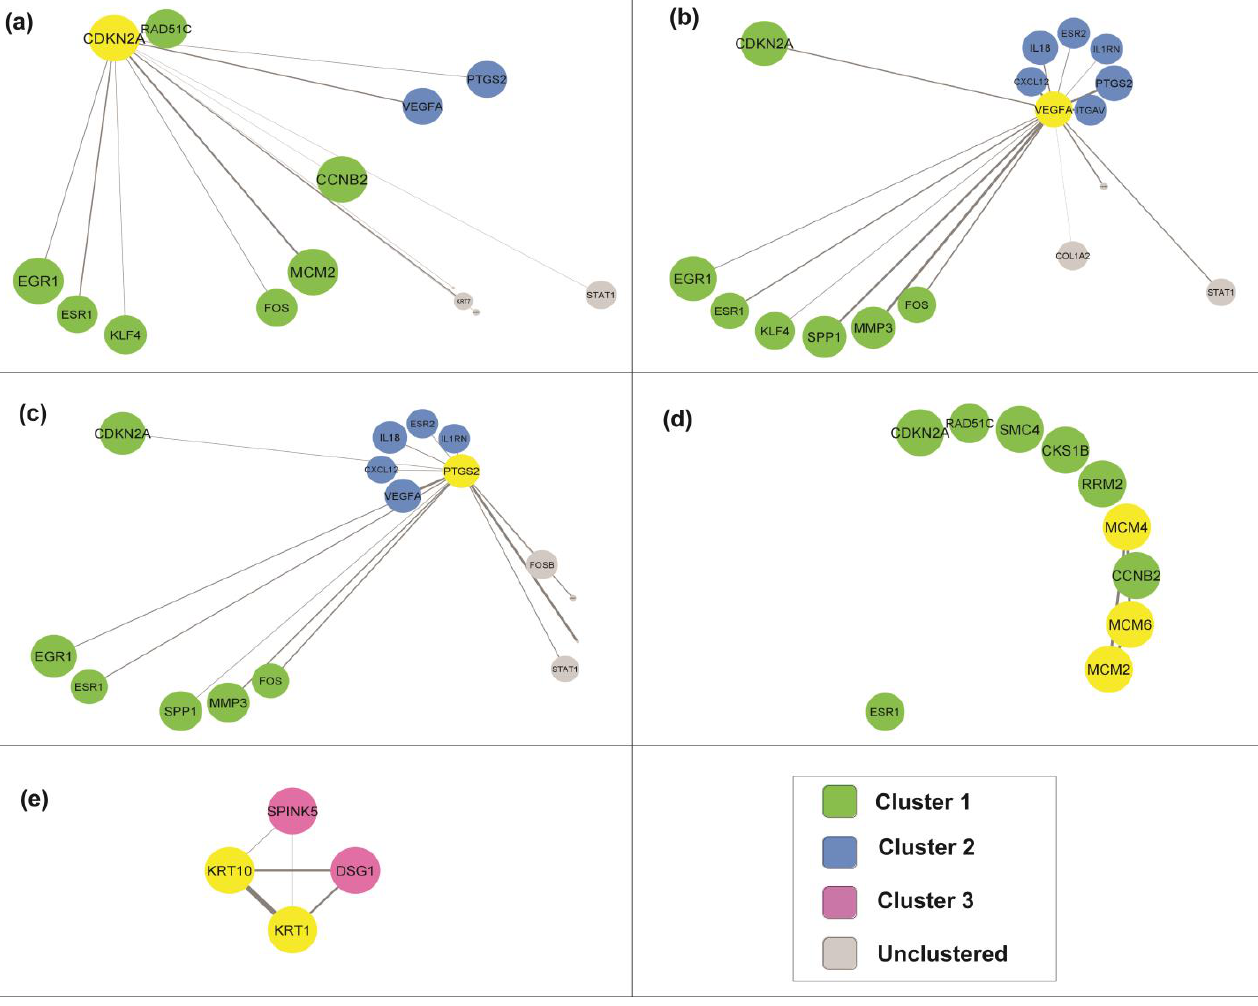
Figure 4. Protein interaction through undirected first neighbor of the candidate genes (highlighted in yellow) from cluster 1: ( a ) CDKN2A , ( b ) VEGFA , ( c ) PTGS2 , ( d ) MCM family, and ( e ) KRT family.